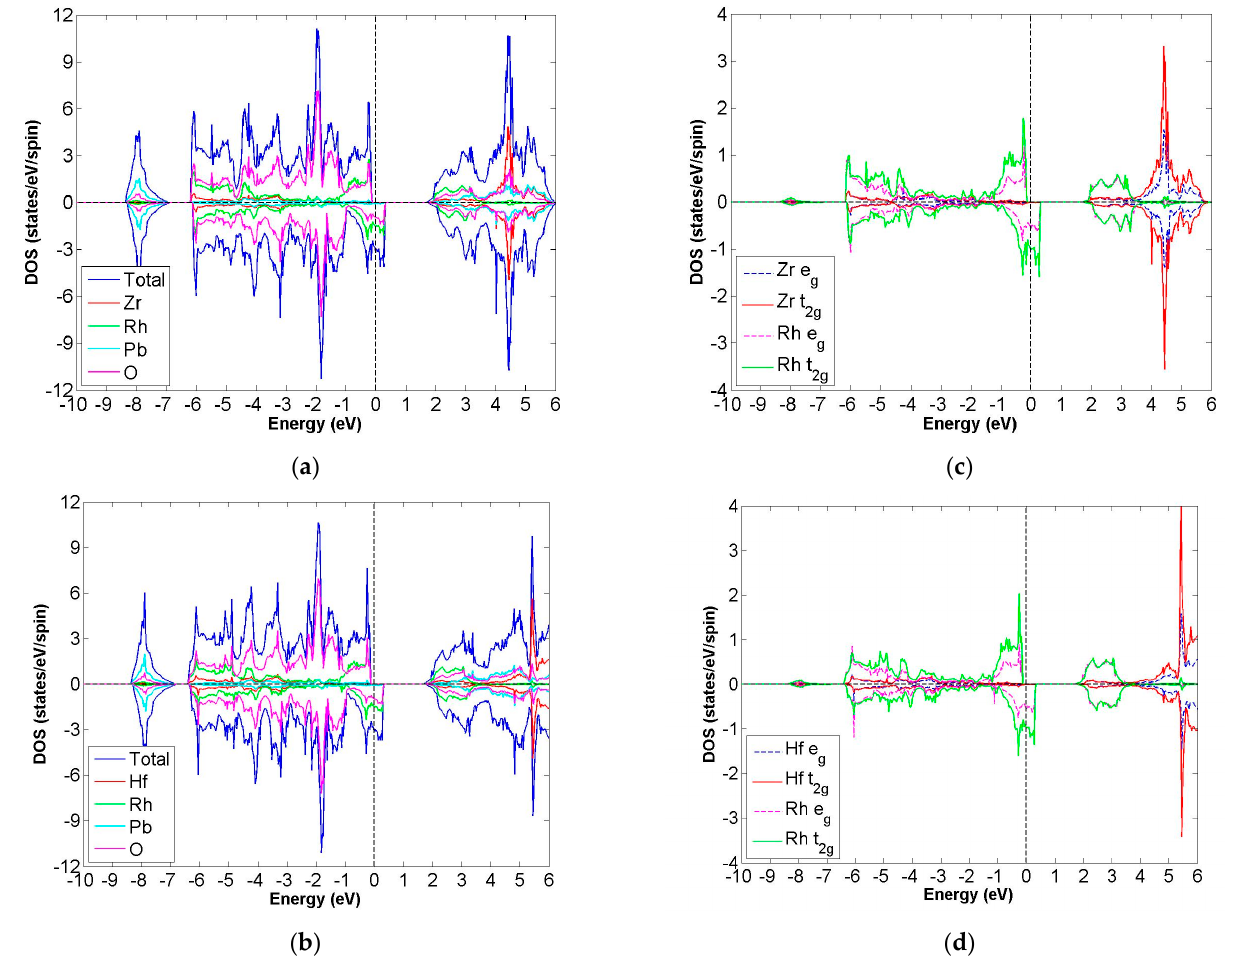
Figure 10. Under GGA + U (U of Zr, Hf and Rh set up as 2) schemes, the calculated total and partial DOS values of ( a ) Pb 2 ZrRhO 6 , ( b ) Pb 2 HfRhO 6 and the partial DOS of e g and t 2g spin orbitals for ( c ) Zr and Rh and ( d ) Hf and Rh.